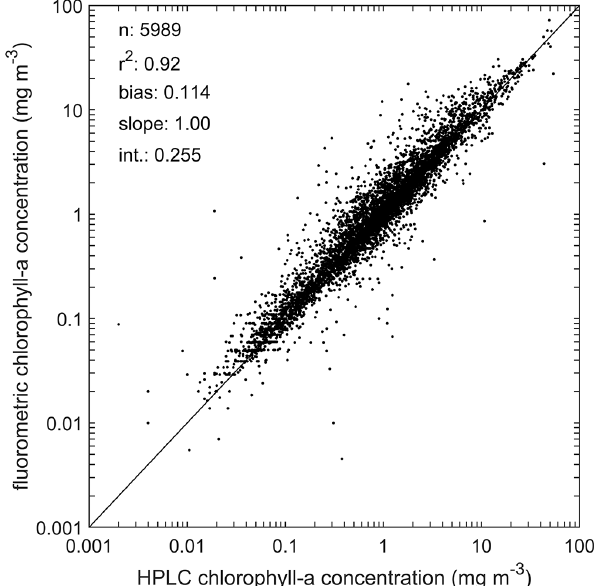
Figure 6. Comparison of coincident observations of chlorophyll- a concentration derived with different methods (“chla_fluor” and “chla_hplc”). The data were transformed prior to regression analy- sis to account for their log-normal distribution.